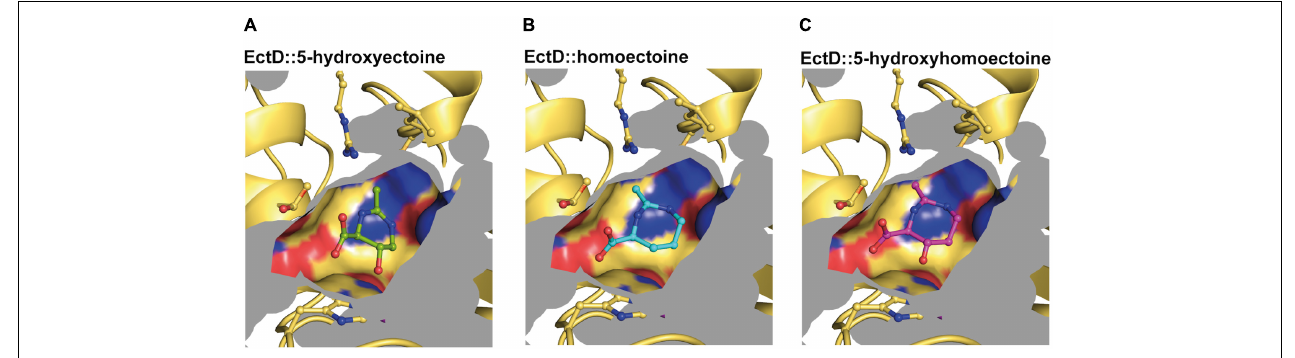
FIGURE 8 | Modeling and docking of different substrates into the crystal structure of the ectoine hydroxylase EctD from S. alaskensis. The cavity of the active site of the Sa EctD enzyme (PDB accession code: 4Q5O) is shown with (A) the natural reaction product 5-hydroxyectoine, (B) the synthetic substrate homoectoine, and (C) the synthetic reaction product